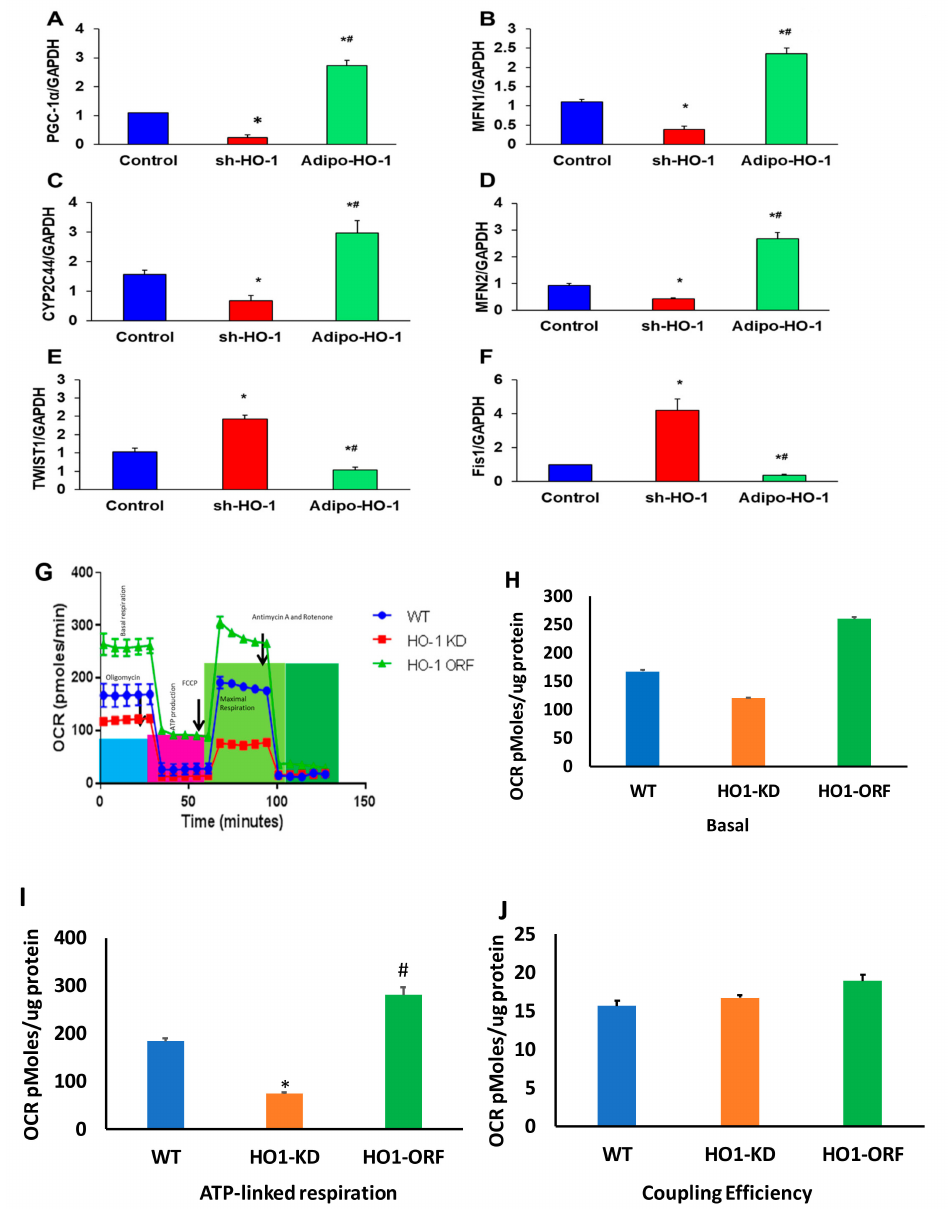
Figure 7. Heme oxygenase-dependent regulation of mitochondrial dynamics and inflammation in vitro. Quantitative gene expression analysis of ( A ) PGC-1 α , ( B ) MFN1, ( C ) Cyp2c44, ( D ) MFN2, ( E ) Twist1, and ( F ) Fis1, n = 3, * p < 0.05 versus control; # p < 0.05 versus sh-HO-1. ( G ) HO-1 regulation of mitochondrial function in adipocyte cell culture. ( H ) Basal of OCR, ( I ) ATP-linked respiration, and ( J ) coupling e ffi ciency. Oxygen-consumption rates (OCR) of sh-HO-1 (HO-1 KD), Lnv-adipo-HO-1 (HO-1 ORF), and control cultured adipocytes, n = 3, * p < 0.05 versus control, # p < 0.05 vs. HO-1